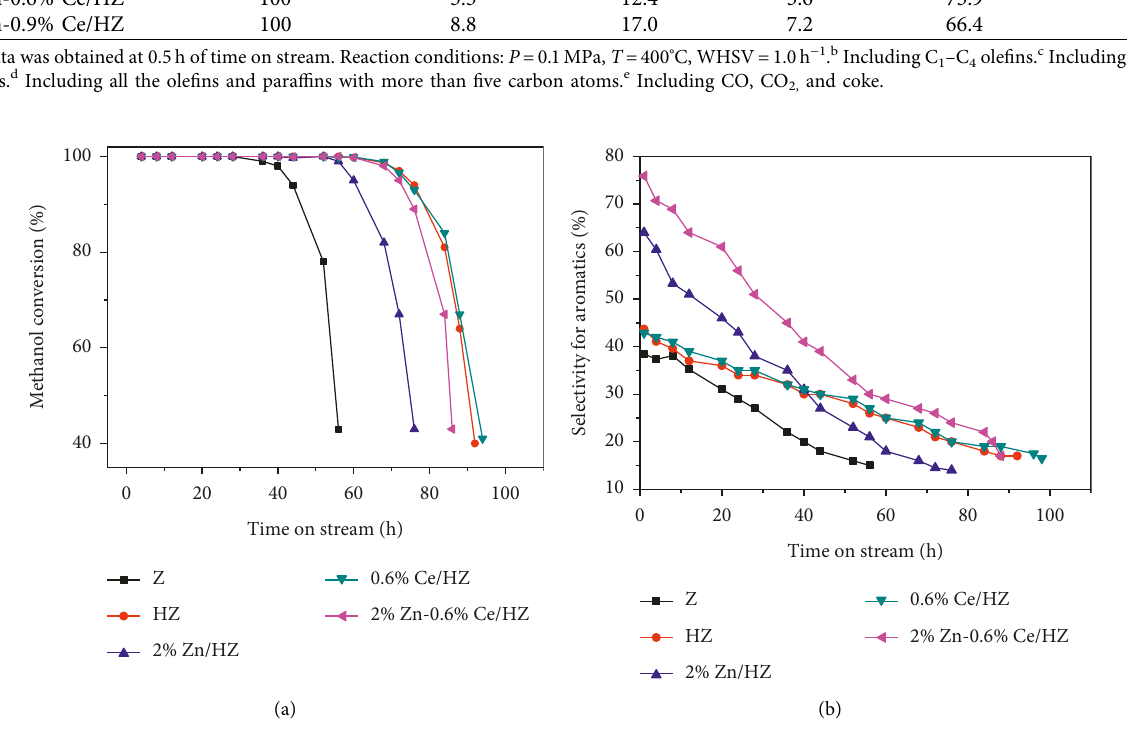
Figure 1: Methanol conversion (a) and selectivity for aromatics (b) versus time on stream (reaction condition: T � 400 ° C, WHSV � 1.0 h − 1 , P �